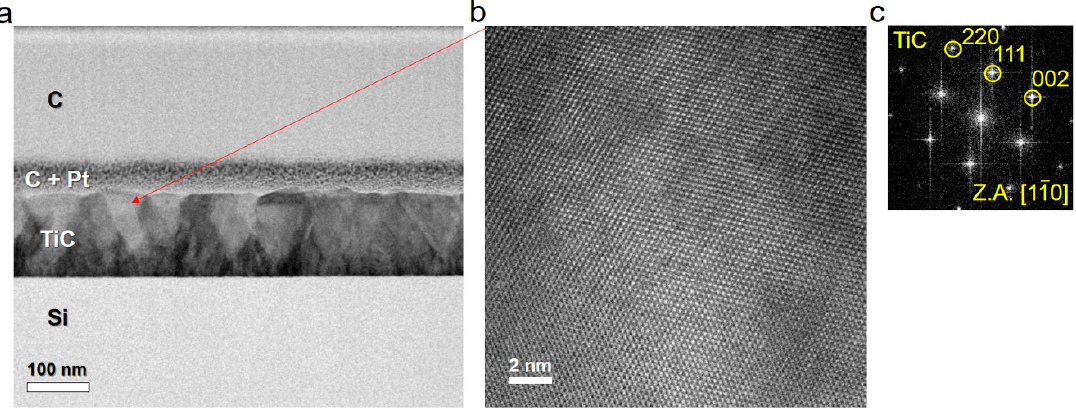
Figure 11. ( a ) Cross-sectional bright field (BF) STEM image of the TiC layer on Si for the 5% CH 4 / 15 min sample; ( b ) STEM-ADF image from a top bright disoriented grain in ( a ) with the FFT pattern shown in ( c ).